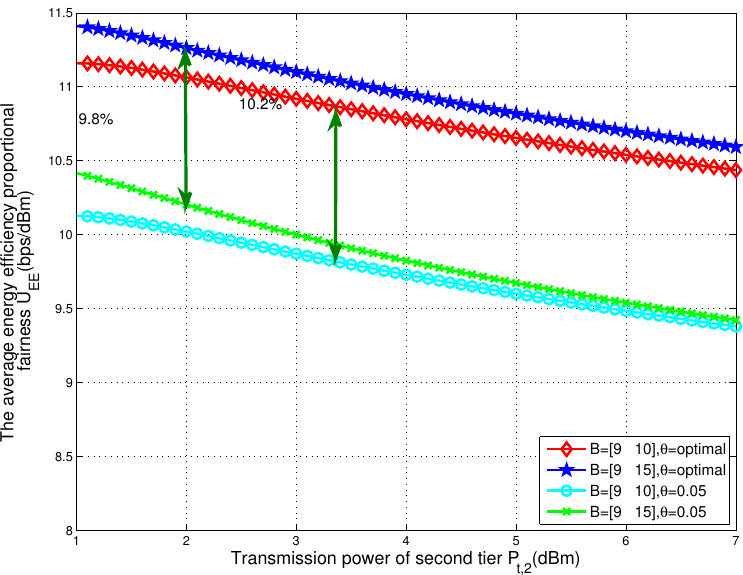
Figure 3. Energy efficiency proportional fairness of total two-tier heterogeneous WPCNs with respect to the transmit power of BSs in tier 2 for different values of the tier-2 cell association bias